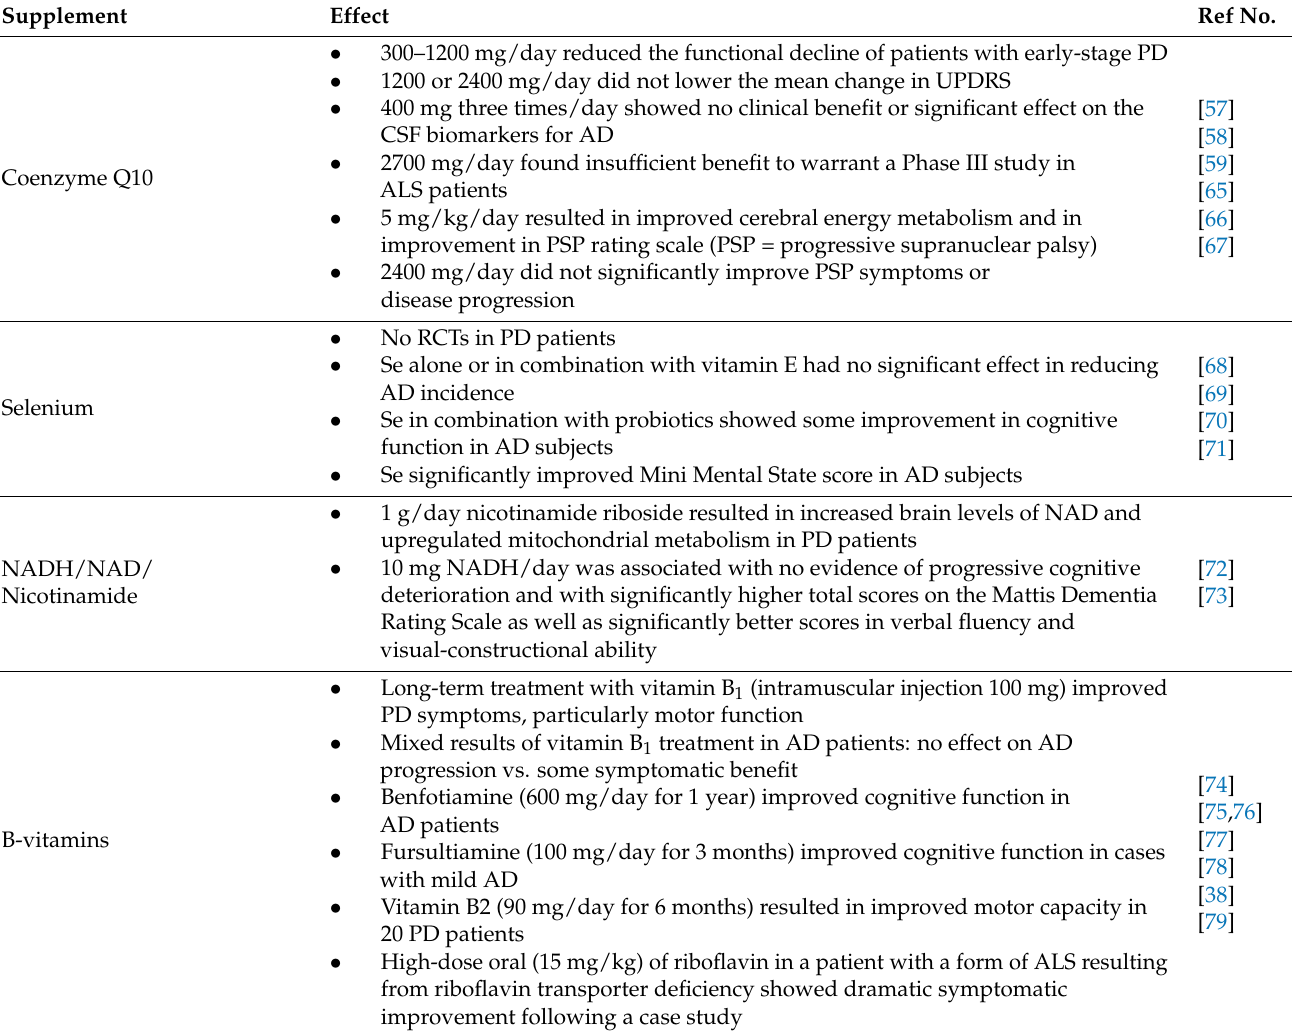
Table 2. Nutritional supplementation in neurodegenerative